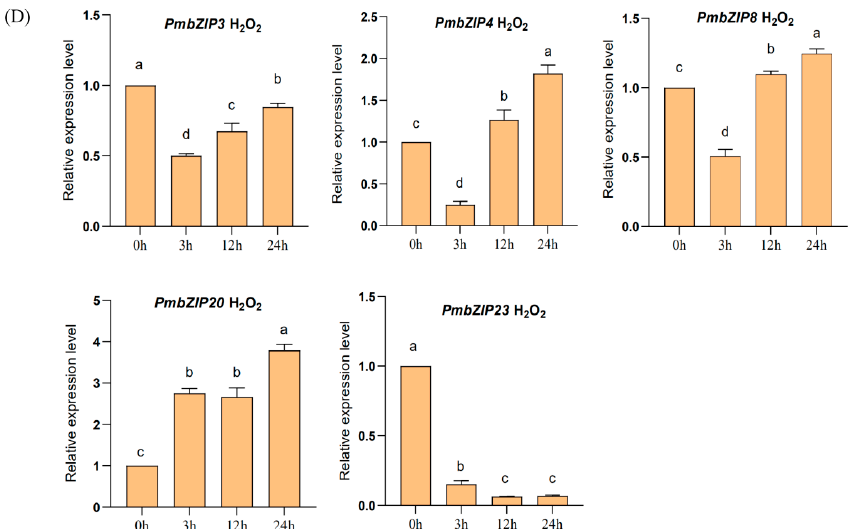
Figure 7. The expression levels of PmbZIPs in different treatments. ( A ) SA; ( B ) MeJA; ( C ) ETH; ( D ) H 2 O 2 . The relative expression level is indicated as the mean ± standard deviation (SD). Different letters show significant differences at the 0.05 level with the Duncan method.